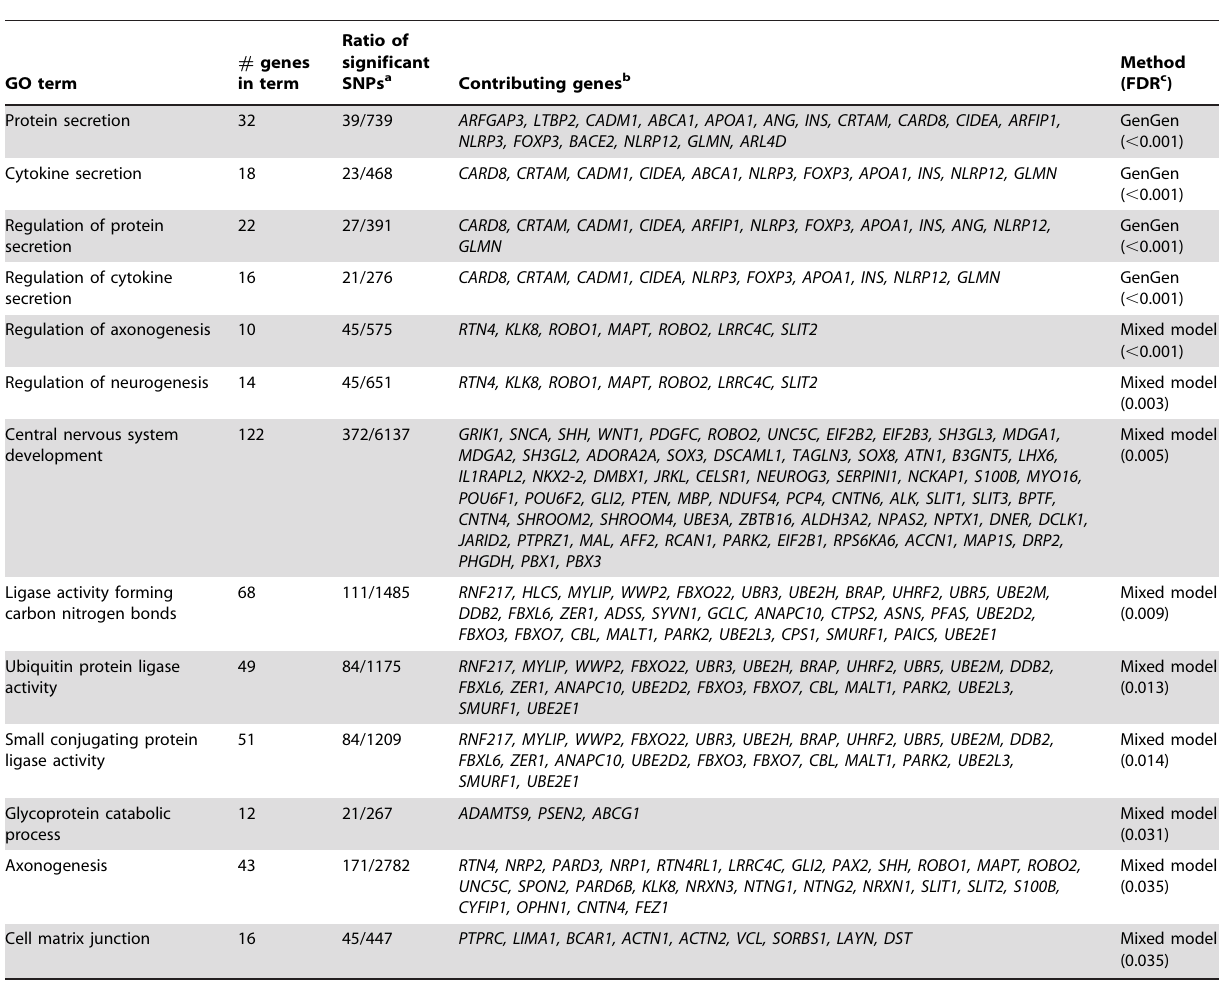
Table 1. Gene Ontology (GO) terms significantly associated with dental caries (FDR ,